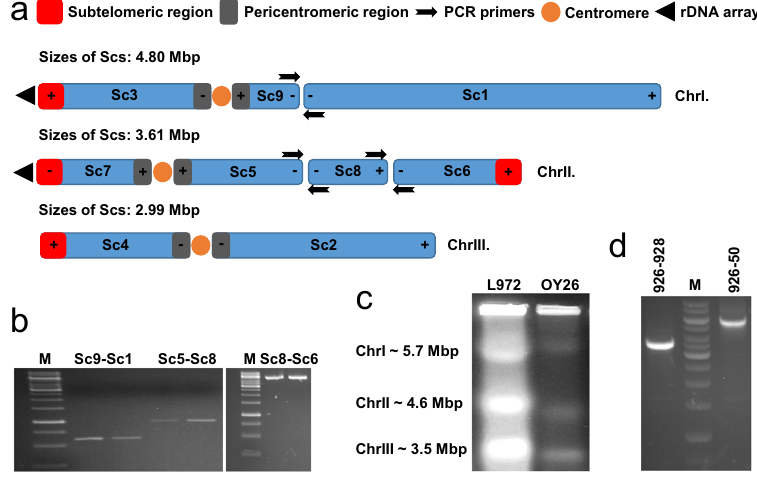
Figure 2. ( a ) Hypothetic chromosomes of S. cryophilus and positions of the primers (black arrows). “ + ” and “ − ” indicate the original orientation of the supercontigs available in the corresponding databases. In the case of ( +− ) the orientation coincides with the default orientation, ( −+ ) refers to inverted orientations. ( b ) PCR validation of togetherness of Sc9-Sc1 (lane: 1., 2.; primers: 666–667), Sc5-Sc8 (lane: 3.,4.; primers: 668–669) and Sc8-Sc6 (lane: 5.,6.; primers: 794–795) supercontig pairs. M: 1 Kb DNA ladder. ( c ) Pulsed-field gel electrophoresis of the chromosomal DNA of S. pombe (L972) and S. cryophilus (OY26). ( d ) PCR validation of localisation of the rDNA arrays on the S. cryophilus chromosomes. M: 1 Kb DNA ladder; 926, 928, 50: PCR primers. Gel photos of ( b – d ) are cropped, full-length gels are presented in Supplementary Figs